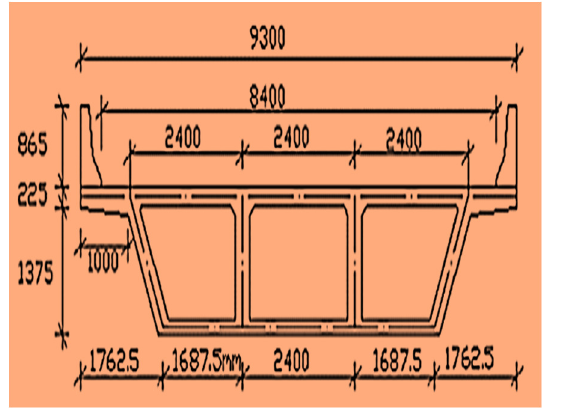
FIG. 1: CROSS SECTION OF SELECTED BOX GIRDER SUPERSTRUCTURE